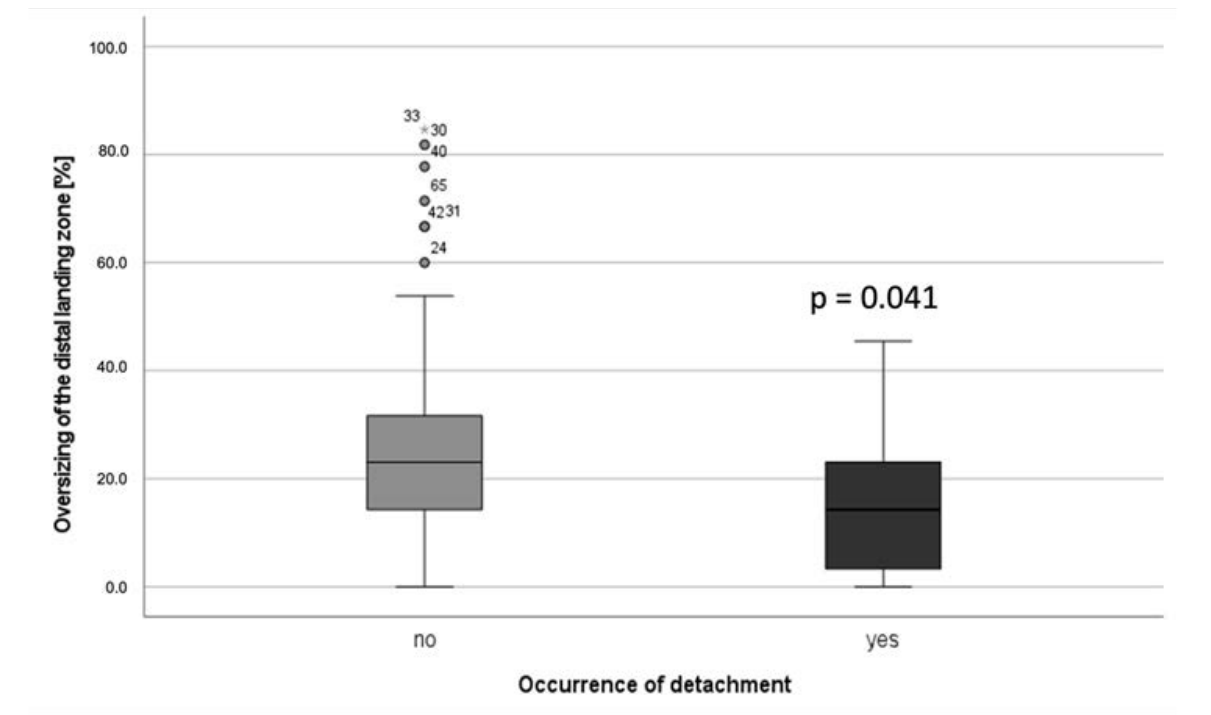
Figure 4. Median oversizing in patients without detachment vs. patients with detachment. (cid:70) ( = extreme